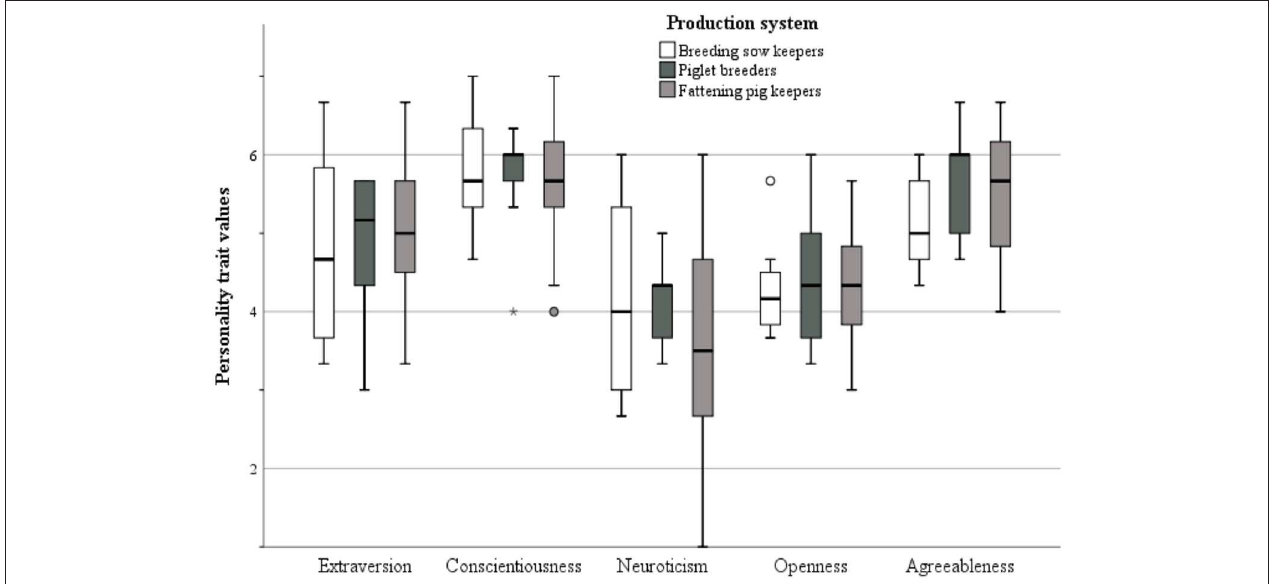
FIGURE 3 | Box-and-whisker plot of personality trait values according to the pig production system: breeding sow keeper ( N = 8), piglet breeders ( N = 10) and fattening pig keepers ( N =